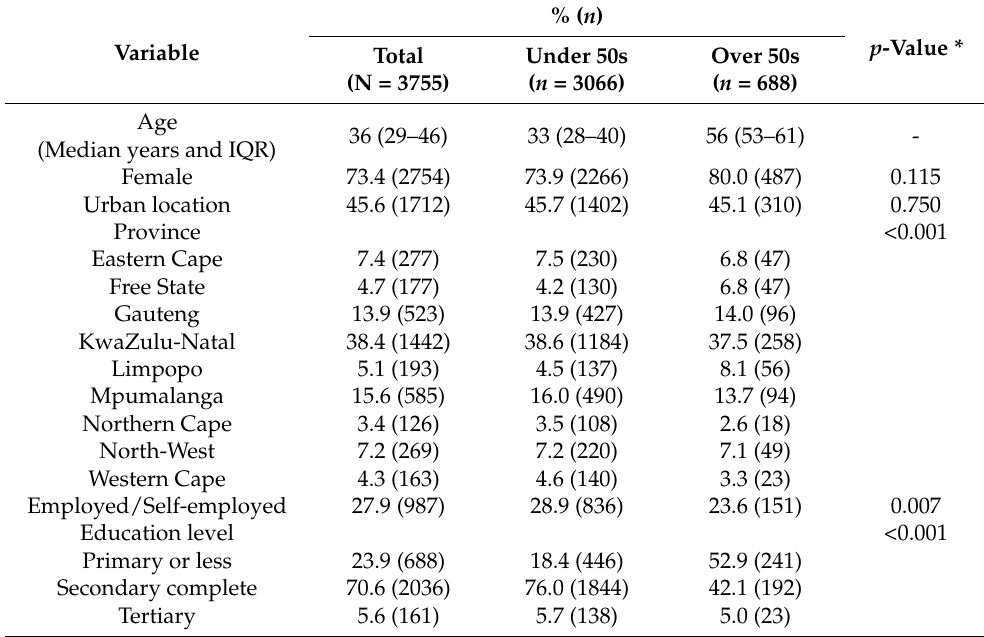
Table 1. Sociodemographic characteristics of adults who tested HIV positive by age (under 50 years vs. 50 years and older), SABSMM 2017.